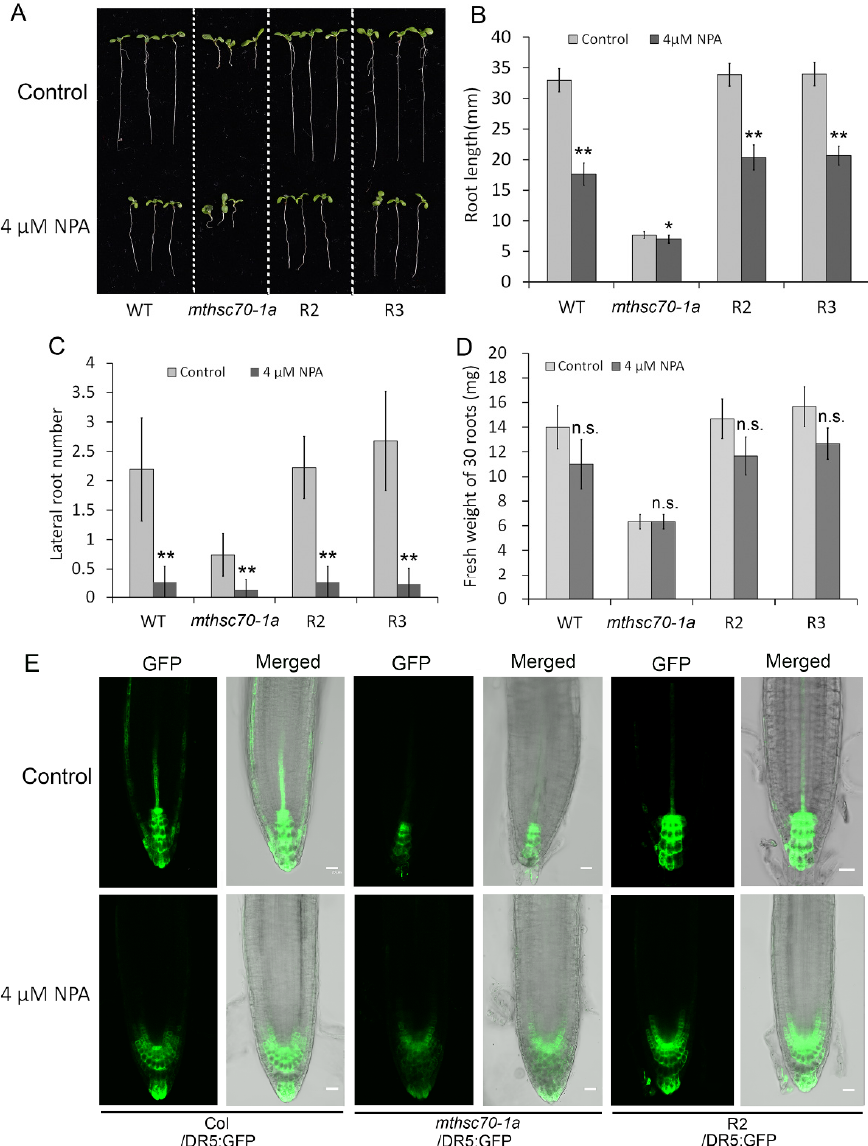
Figure 4. The effects of NPA treatment on root growth and auxin distribution. ( A – D ) The effect of NPA treatment on root growth in WT, mthsc70-1a , R2 and R3 seedlings. Representative seedlings after 10 days of growth in 0.5 × MS medium with or without 4 μ M NPA and shown ( A ). Comparison of root length ( B ), lateral root number ( C ) and fresh weight ( D ) among WT, mthsc70-1a , R2 and R3 seedlings. The asterisks indicate significant differences from control group with the same genotype ( t -test; *, p < 0.05; **, p < 0.01). n.s., no significant differences from the control group. ( E ) The effect of NPA treatment on auxin distribution in root tips. Roots of 5 days old Col/ DR5:GFP , mthsc70-1a/DR5:GFP and R2/ DR5:GFP seedlings grown in 0.5 × MS medium with or without 4 µ M NPA were observed using a LSCM. Representative images are shown. Scale bar = 20 µ m. WT, wild type; mthsc70-1a ,